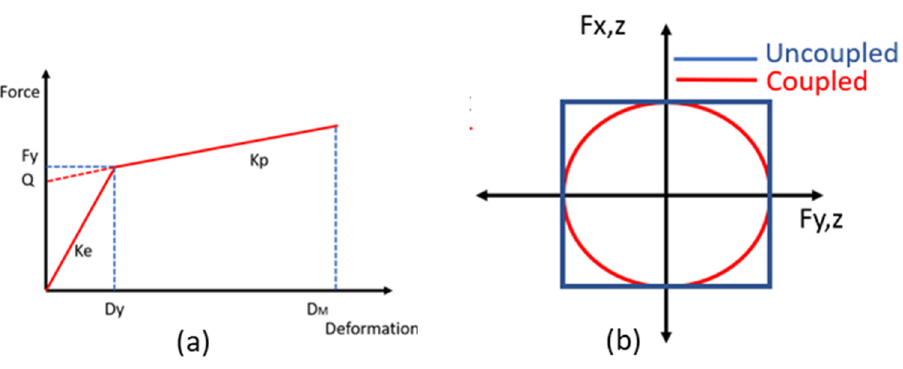
Figure 7. ( a ) Idealized bilinear response of LRB ( b ) circular yield surface for coupled plasticity.